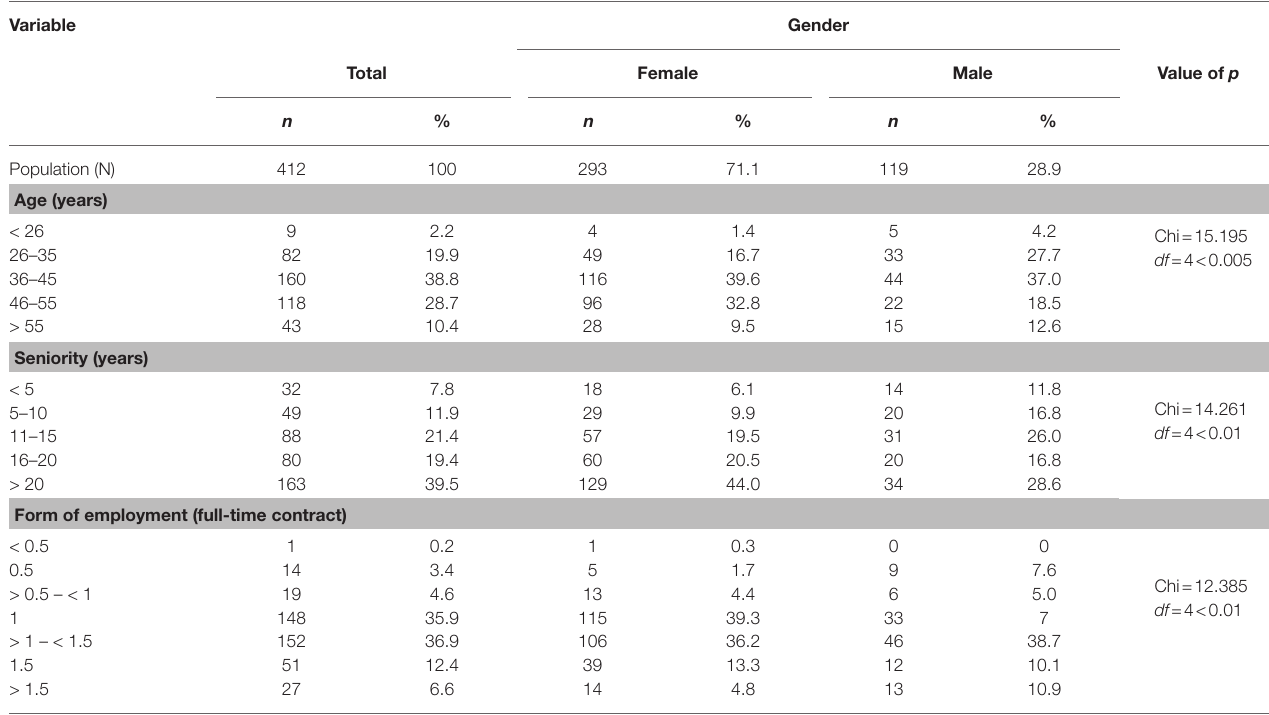
TABLE 1 | Characteristics of the study